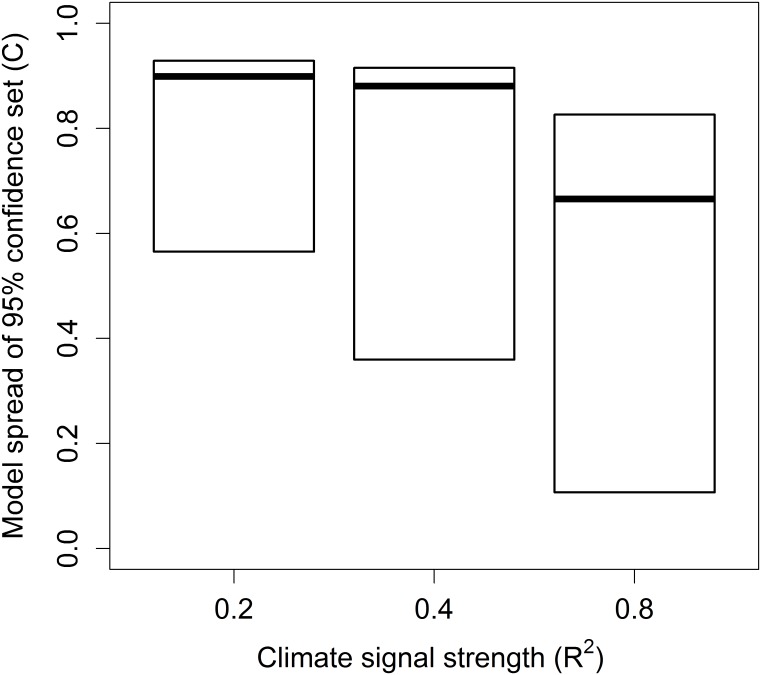
Relationship between the percentage of models in the 95% confidence set and climate signal strength.Percentage of models in the 95% confidence set (C) are shown for a very strong (R2 = 0.8), strong (R2 = 0.4), and moderate climate signal (R2 = 0.2). Boxes represent median and inter-quartile range. Data from 2,000 simulated datasets, see Section 3 for methods.